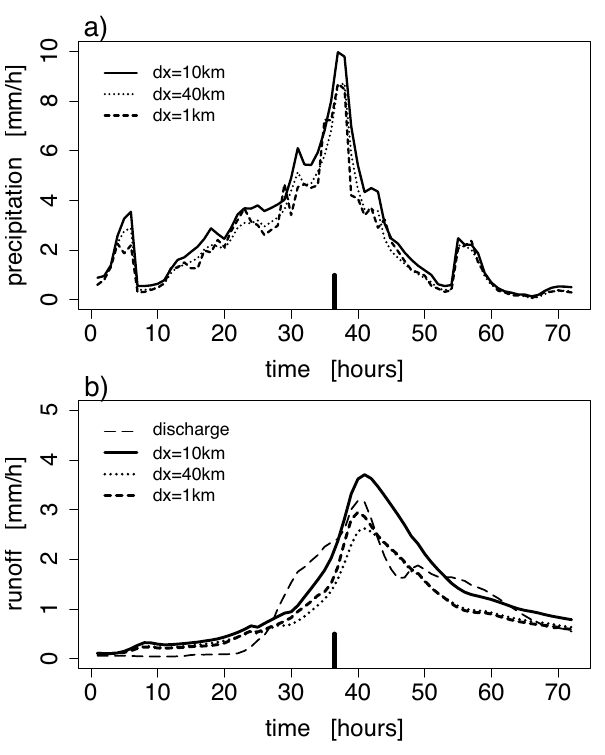
Fig. 9. Same as Fig. 5, but showing results with ALADIN-nh pre- cipitation products: raw forecast with 4km, spatially aggregated forecast with 16km, and downscaled forecast with 1km grid spac-